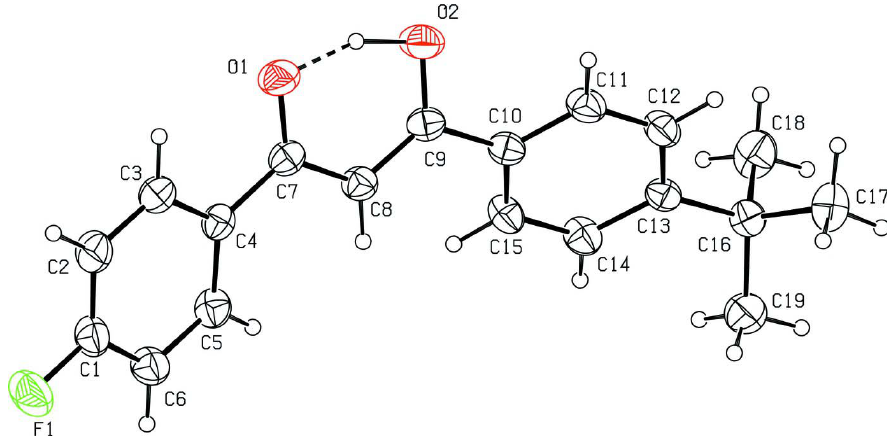
Figure 1 The molecular structure of (I). Displacement ellipsoids are drawn at the 50% probability level. The dashed line indicates a intramolecular hydrogen